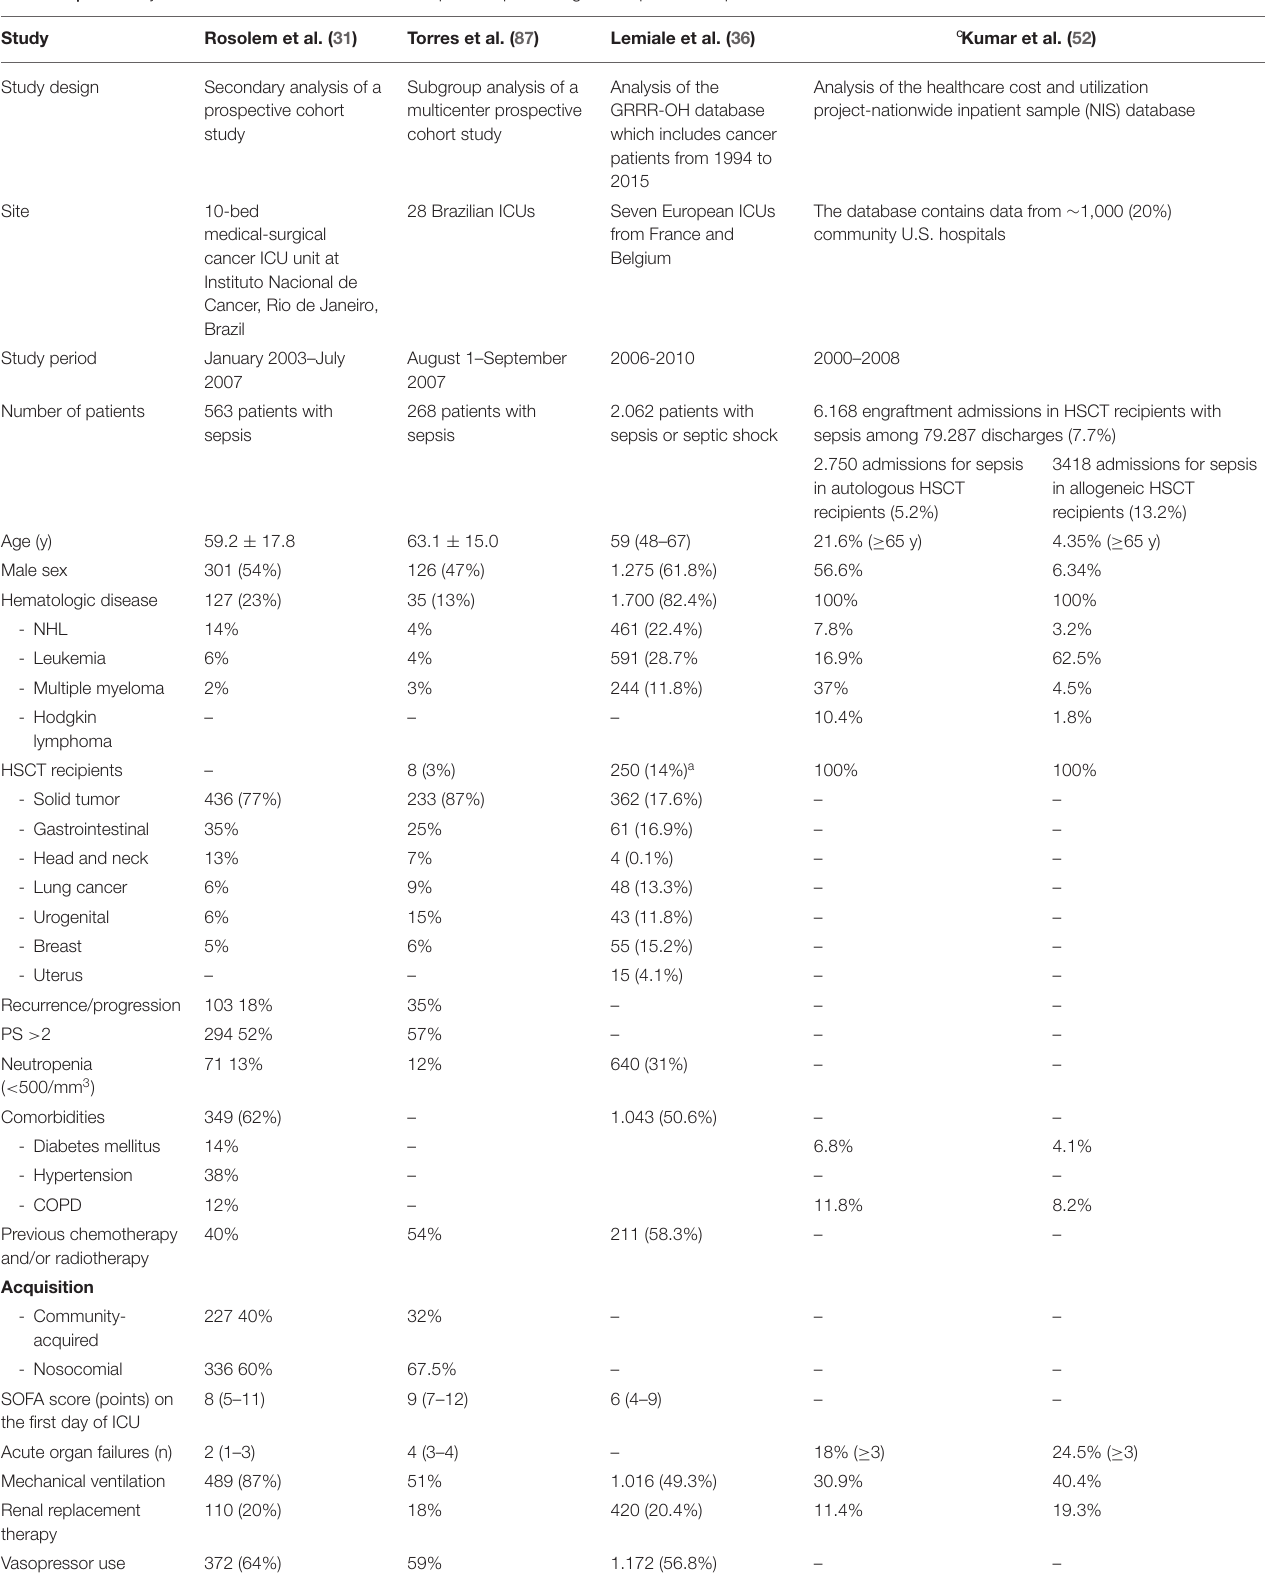
TABLE 1 | Summary of the most relevant series of cancer patients presenting with sepsis and septic